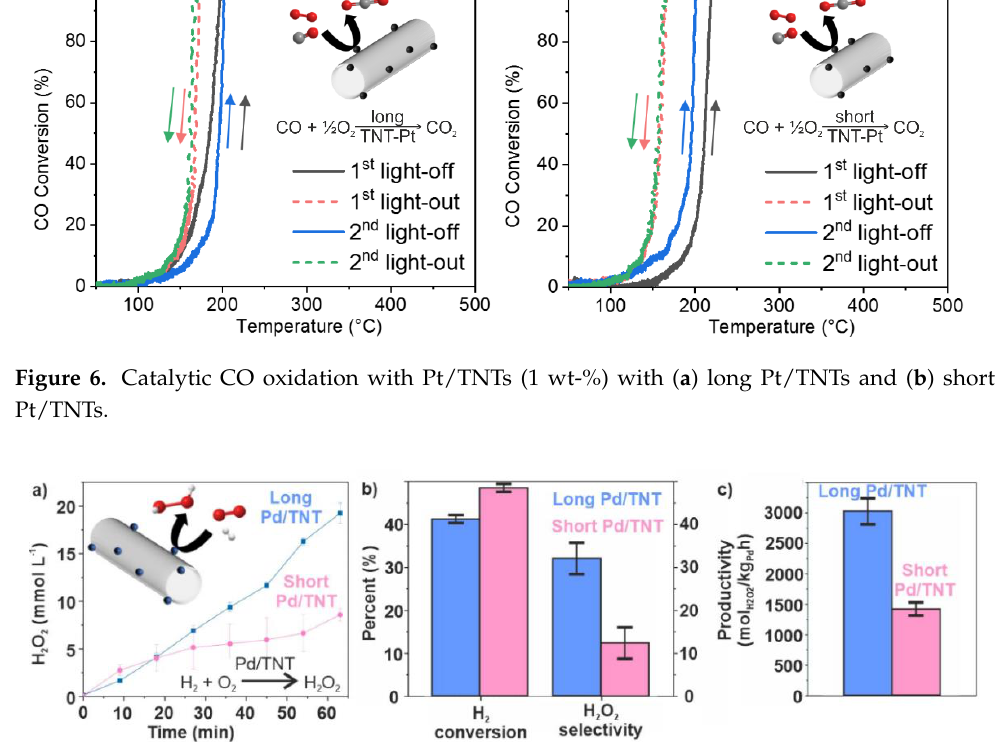
Figure 7. H 2 O 2 direct synthesis with Pd/TNT (5 wt-%) with ( a ) concentration over time, ( b ) H 2 con- version and H 2 O 2 selectivity, and ( c ) H 2 O 2 productivity for long and short